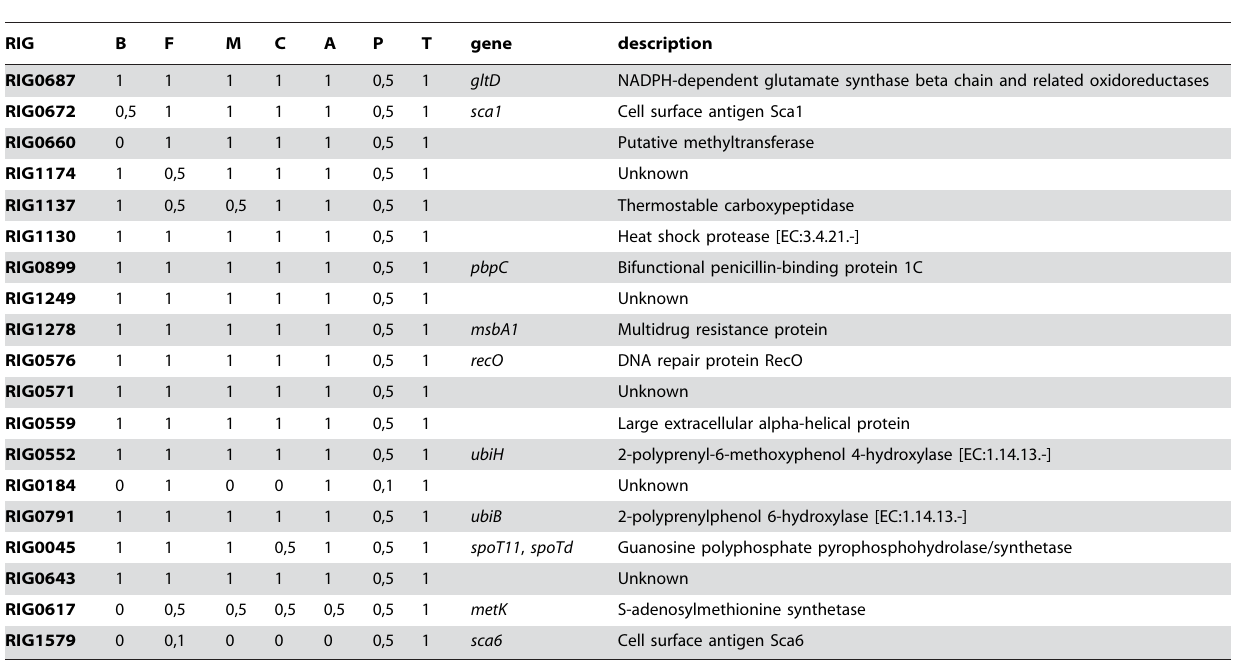
Table 2. Rickettsial genes conserved in R. typhi and degraded in R. prowazekii .